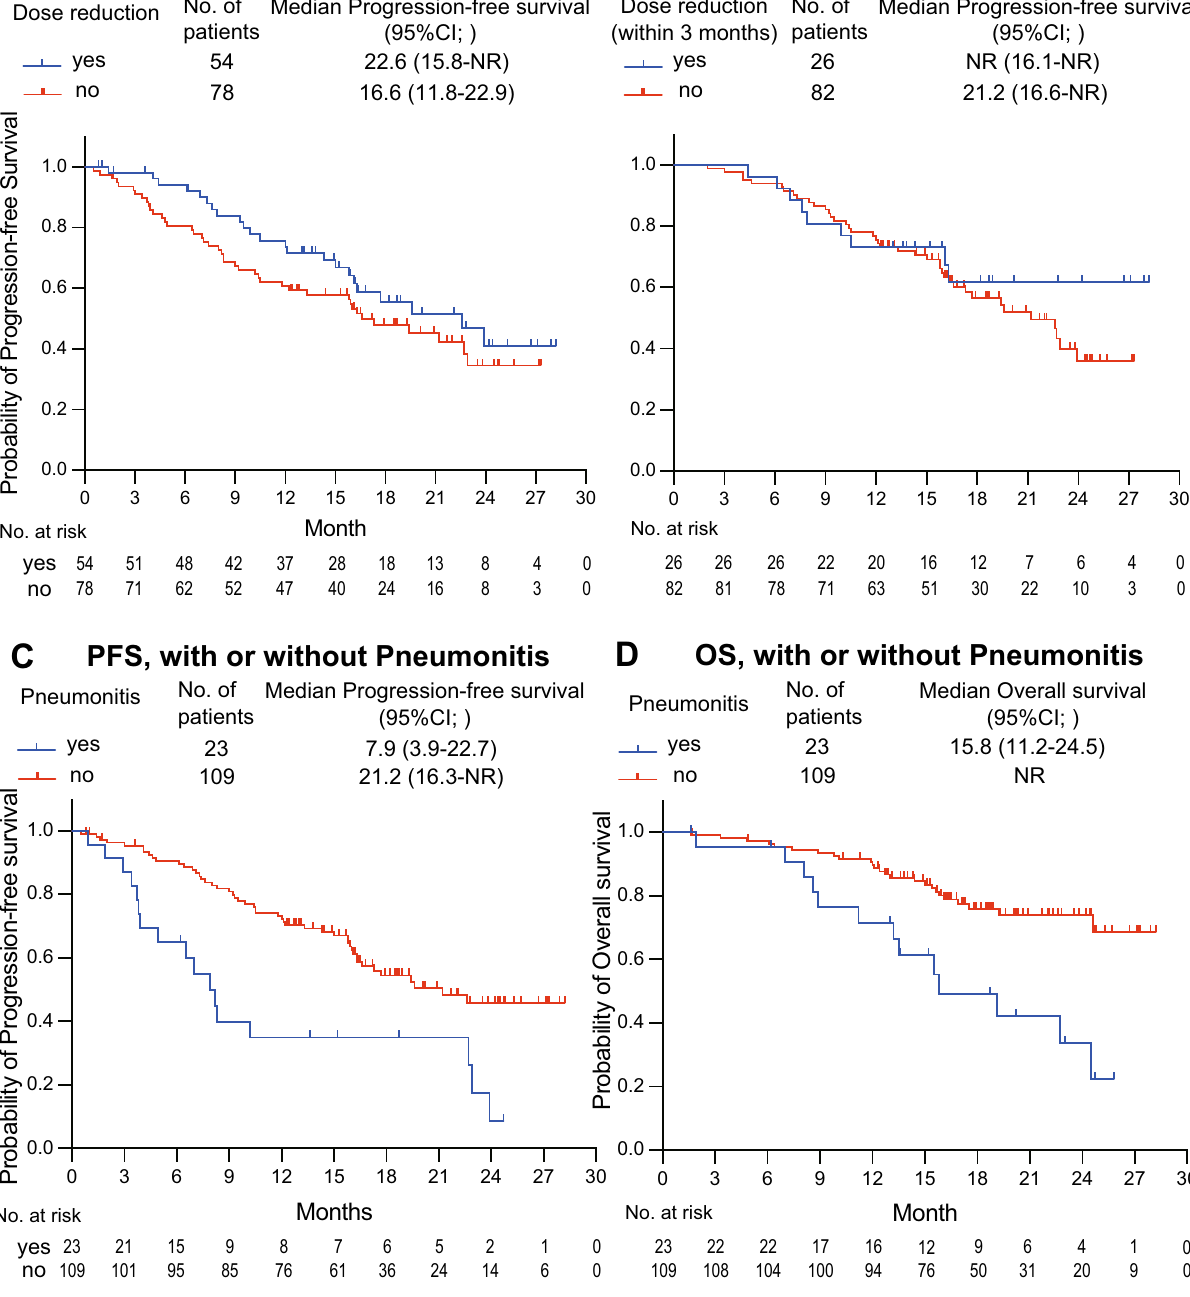
Elderly patients with NSCLC tend to have vulnerable clinical profiles, including lower organ function, poly- pharmacy, or comorbidities, resulting in their often being excluded from prospective clinical trials 4 . Meanwhile, previous prospective and retrospective studies evaluating the efficacy and safety of gefitinib, erlotinib, and afatinib